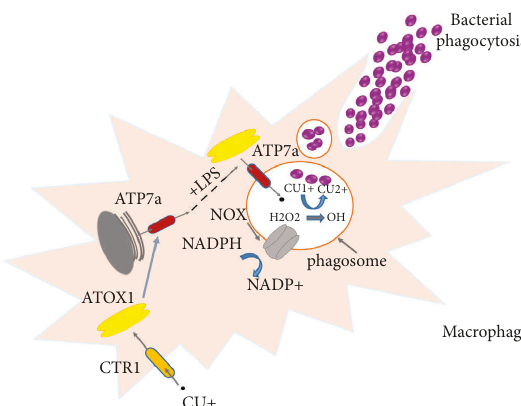
Figure 3: Summary of the mechanism of copper-mediated bac- terial killing by human macrophages. (a). Stimulation of CTR1 in the plasma membrane by inflammatory agents such as lipoproteins. (b) Delivery of cytoplasmic copper to the ATP7a copper pump and loading on phagolysosomes by ATOX copper chaperone. (c) Production of superoxide, followed by spontaneous production of hydrogen peroxide by NADPH (NOX) in the phagosome mem- brane. (d) Increase the bactericidal power of H 2 O 2 by converting it to hydroxyl radicals via Cu (I)-catalyzed